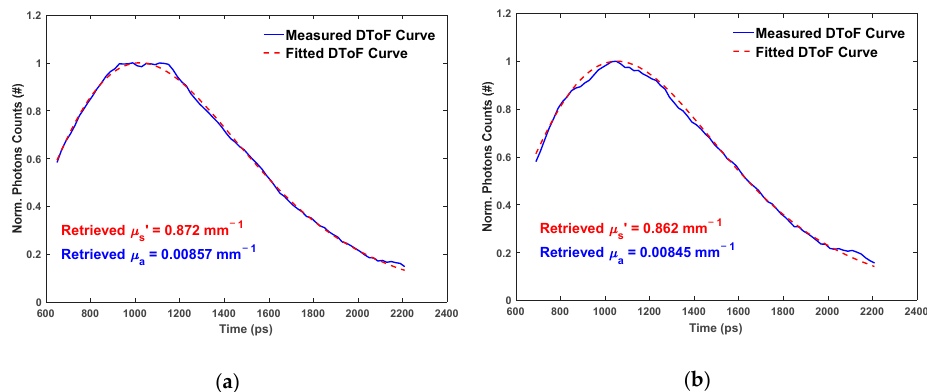
Figure 6. DToF Measured curves and DToF Fitted curves for B2 phantom with SDD = 2.8 cm: ( a ) at 685 nm; and ( b ) at 830 nm.